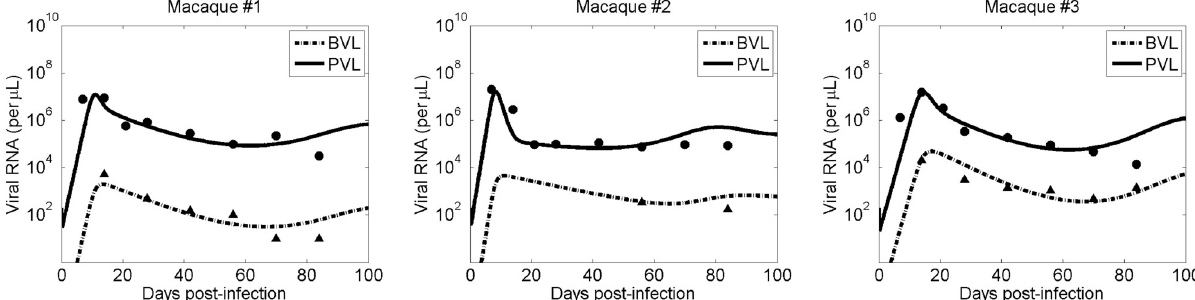
Fig 2. Model fit to the data. Plasma viral load (solid line) and CSF viral load (dashed line) predicted by the selected model, i.e. Model 1, along with the experimental data (filled circle: plasma viral load; filled triangle: CSF viral load) from three monkeys [24, 25].